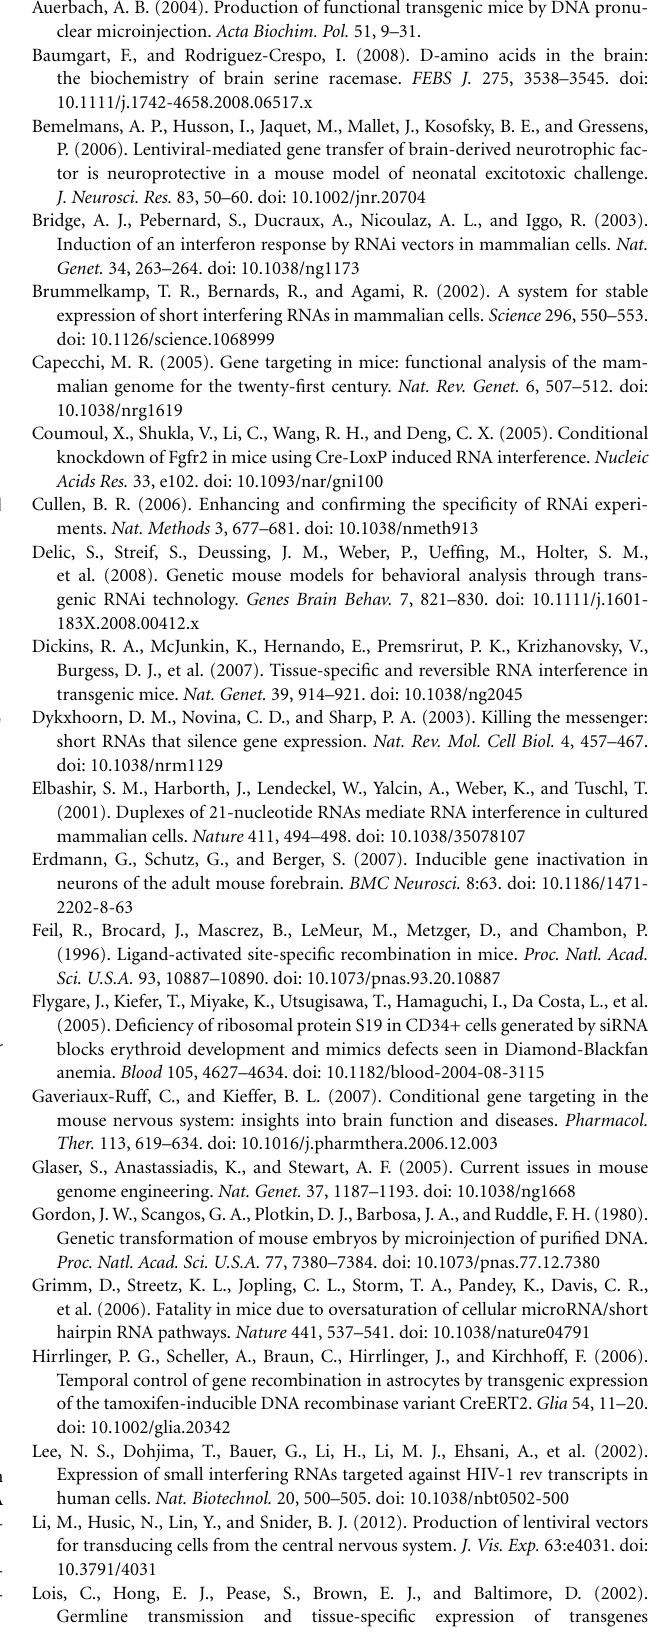
Figure S5 | (A) Coronal section of mouse ventral hippocampus (posterior) stereotactically injected with pSicoR-shRNA3 lentivirus. Brains were isolated 6 weeks after injection, and fresh-frozen sections were collected then analyzed under a fluorescence microscope. A: Ipsilateral hemisphere injected with 2 μ l lentivirus pSicoR-shRNA3 (6 × 10 8 TU/ml); Ventral part coordinates (relative to bregma): AP − 3.16mm, ML ± 3.00mm, DV − 3 to − 2mm; dorsal part coordinates: AP − 2.30mm, ML ± 2.00, DV − 1.5 to − 1.25mm; volume flow: 0.5 μ l.min − 1 ). B: Contralateral non-injected hemisphere (enhanced contrast for identification of hippocampal structures). Scale bar: 160 μ m. (B) Western blot analysis of EGFP expression in hippocampal homogenates three weeks post-injection. β -actin (bottom) was used as loading control. Control, non-injected hemisphere. (C) Regional distribution of transduced cells in the medial